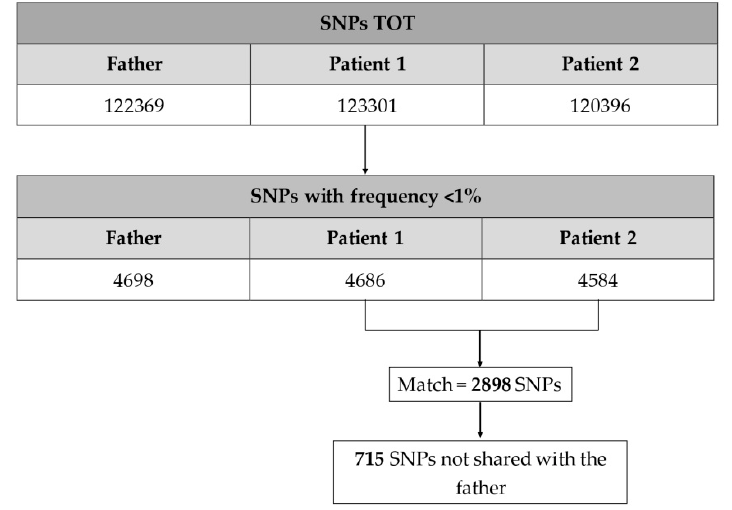
Figure 1. Schematic summary of the process used to filter the single-nucleotide polymorphisms (SNPs) obtained from the whole exome sequencing (WES) report.